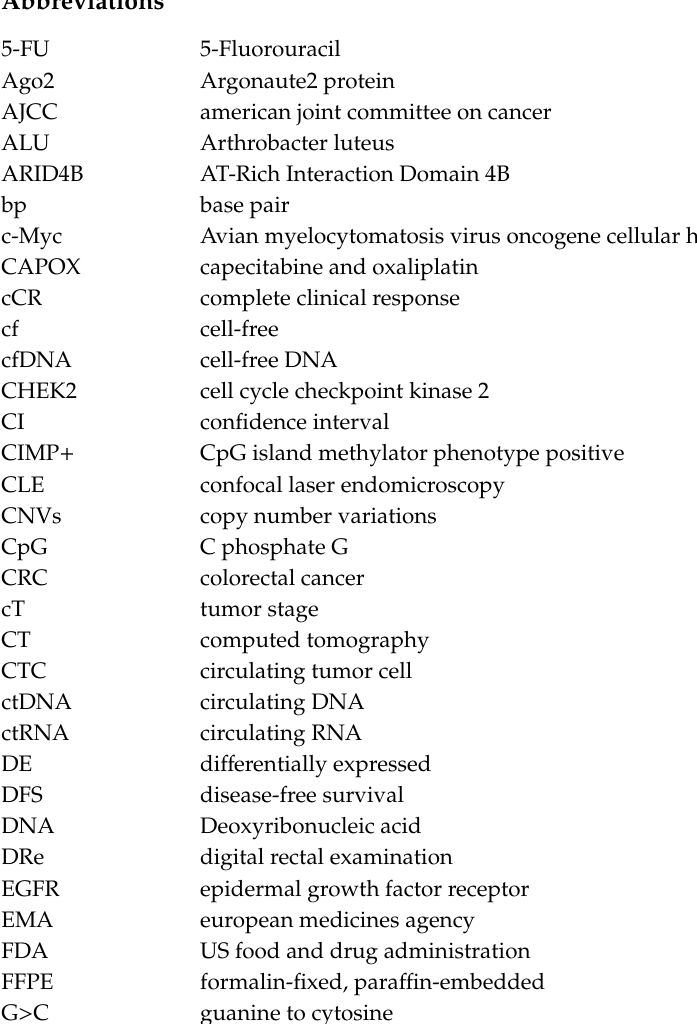
Supplementary Table S1. microRNAs emerged as predictive tissue biomarkers of response to neoadjuvant chemoradiotherapy in locally advanced rectal